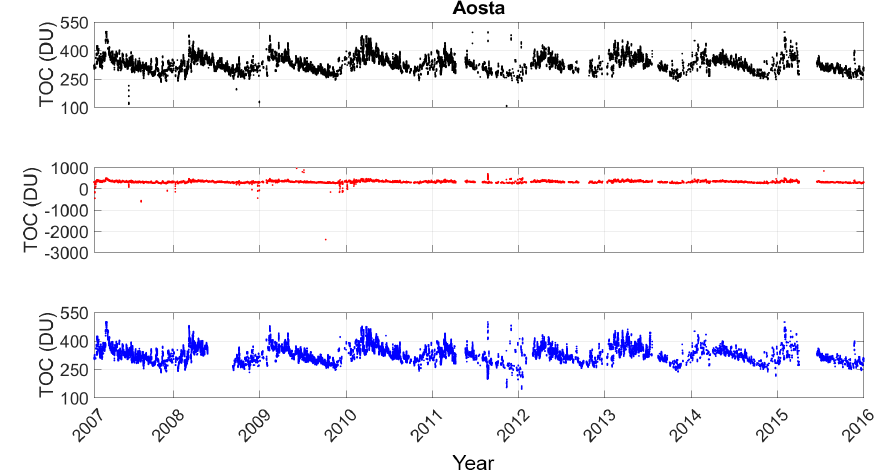
Figure 3. Individual TOC values generated by BPS (black), O3Brewer (red) and EUBREWNET (blue) at Aosta.